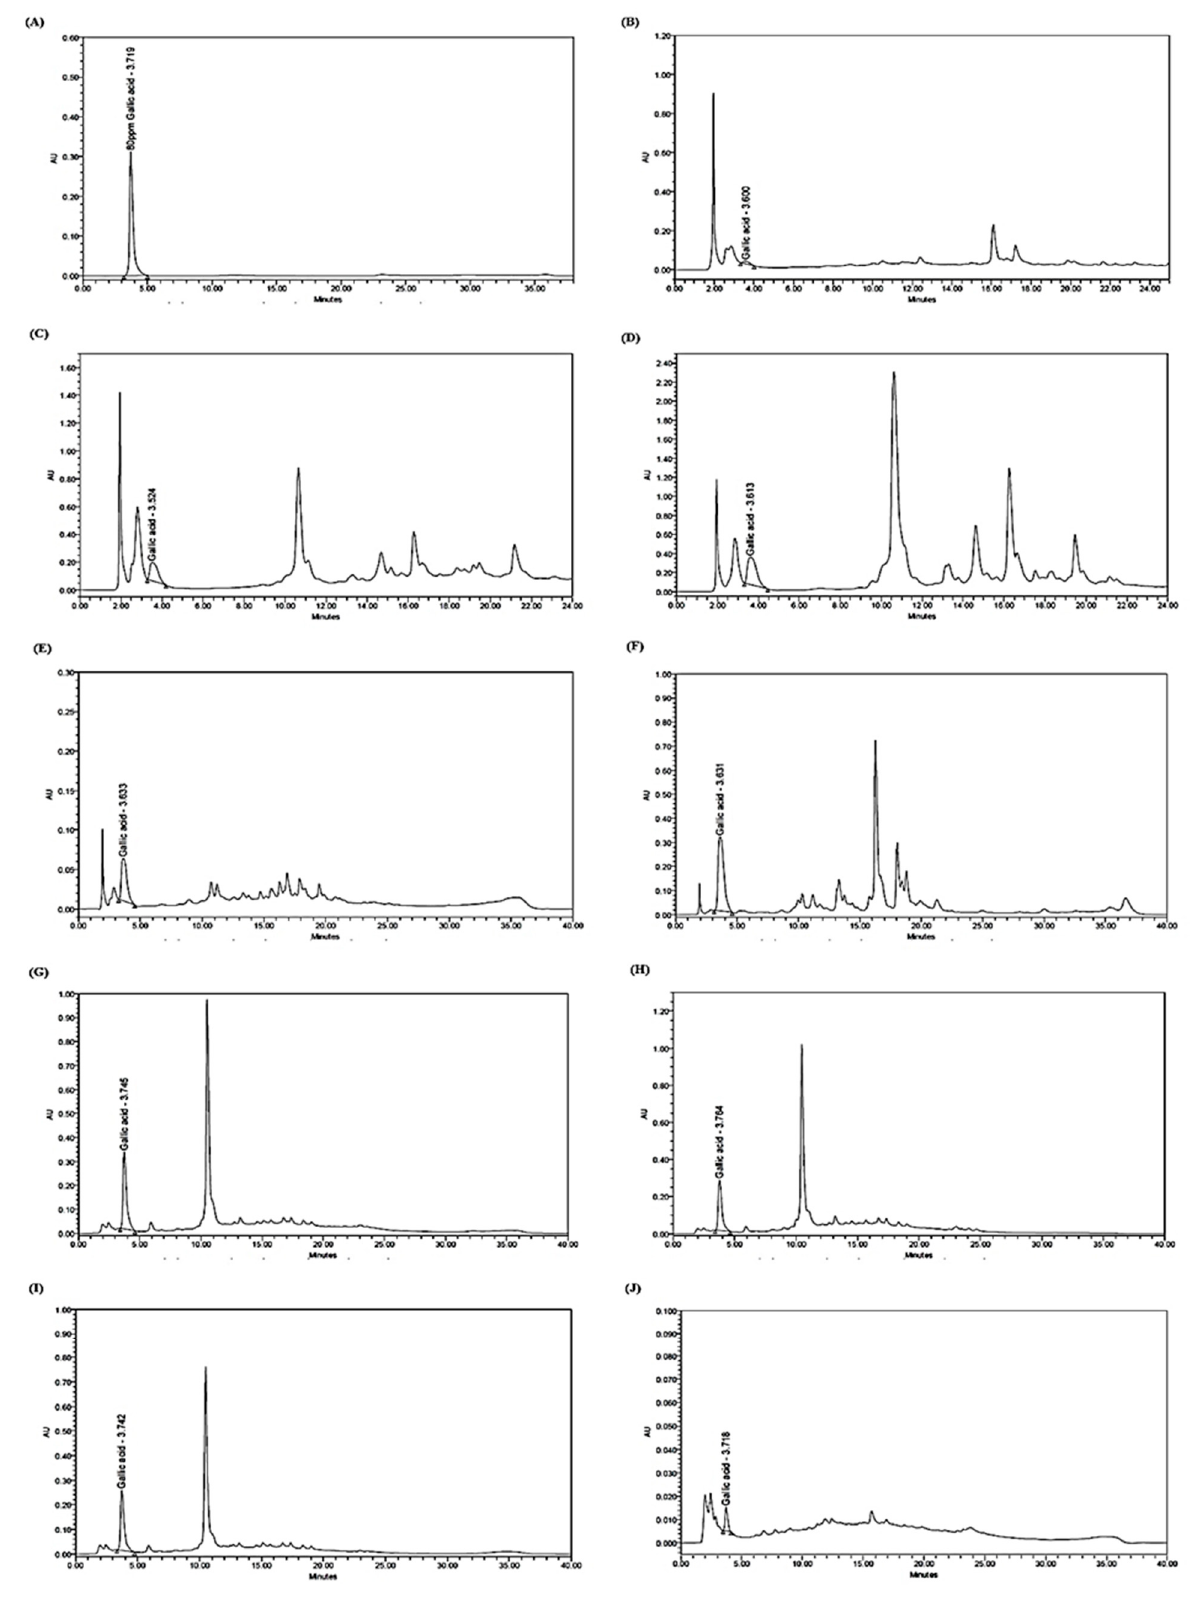
Figure 2. HPLC chromatograms of ( A ) gallic acid standard marker, ( B ) L. pumila var. pumila plant green leaf (LPPG), ( C ) L. pumila var. pumila plant red leaf (LPPR), ( D ) L. pumila var. alata plant (LPA), and L. pumila HMPs ( E ) KFP1, ( F ) KFP2, ( G ) KFP3, ( H ) KFP11, ( I ) KFP12, and ( J ) KFP13.